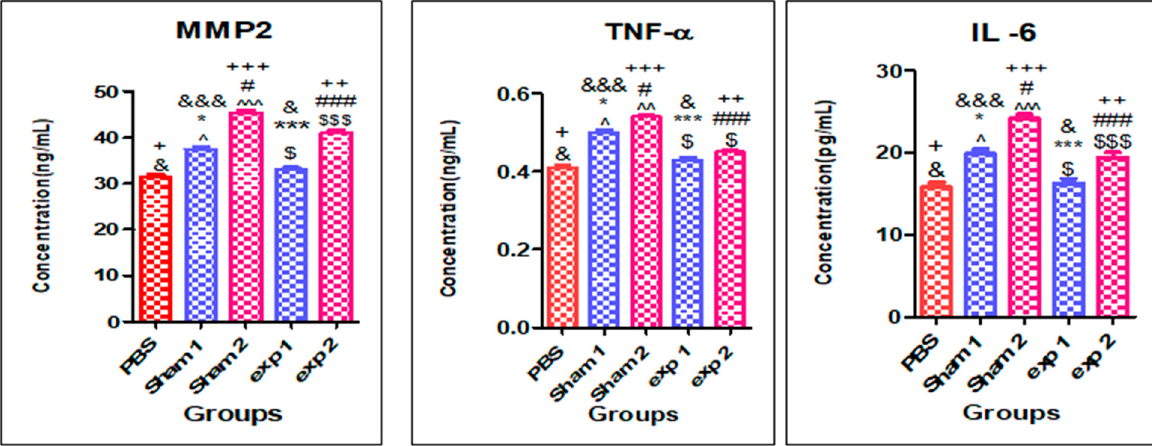
Figure 5. MMP2, IL-6 and TNF- α levels in plasma as measured by ELISA. (* p < 0.05), (** p < 0.01), (*** p < 0.001) show the difference from Sham1; (# p < 0.05), (### p < 0.001) show the difference from Sham2; (& p < 0.05), (&&& p < 0.001) show the difference from PBS group; (+ p < 0.05), (++ p < 0.01), (+++ p < 0.001) show the difference from PBS group; (^ p < 0.05) and (^^^ p < 0.001) show the difference from Sham1 (MMP2,IL-6,TNF- α ); ($ p < 0.05) and ($$$ p < 0.001) show the difference from Exp1 ( MMP2,IL-6, TNF-a). (PBS is the control group and Exp1 and Exp2 are experimental groups #1 and 2 respectively).